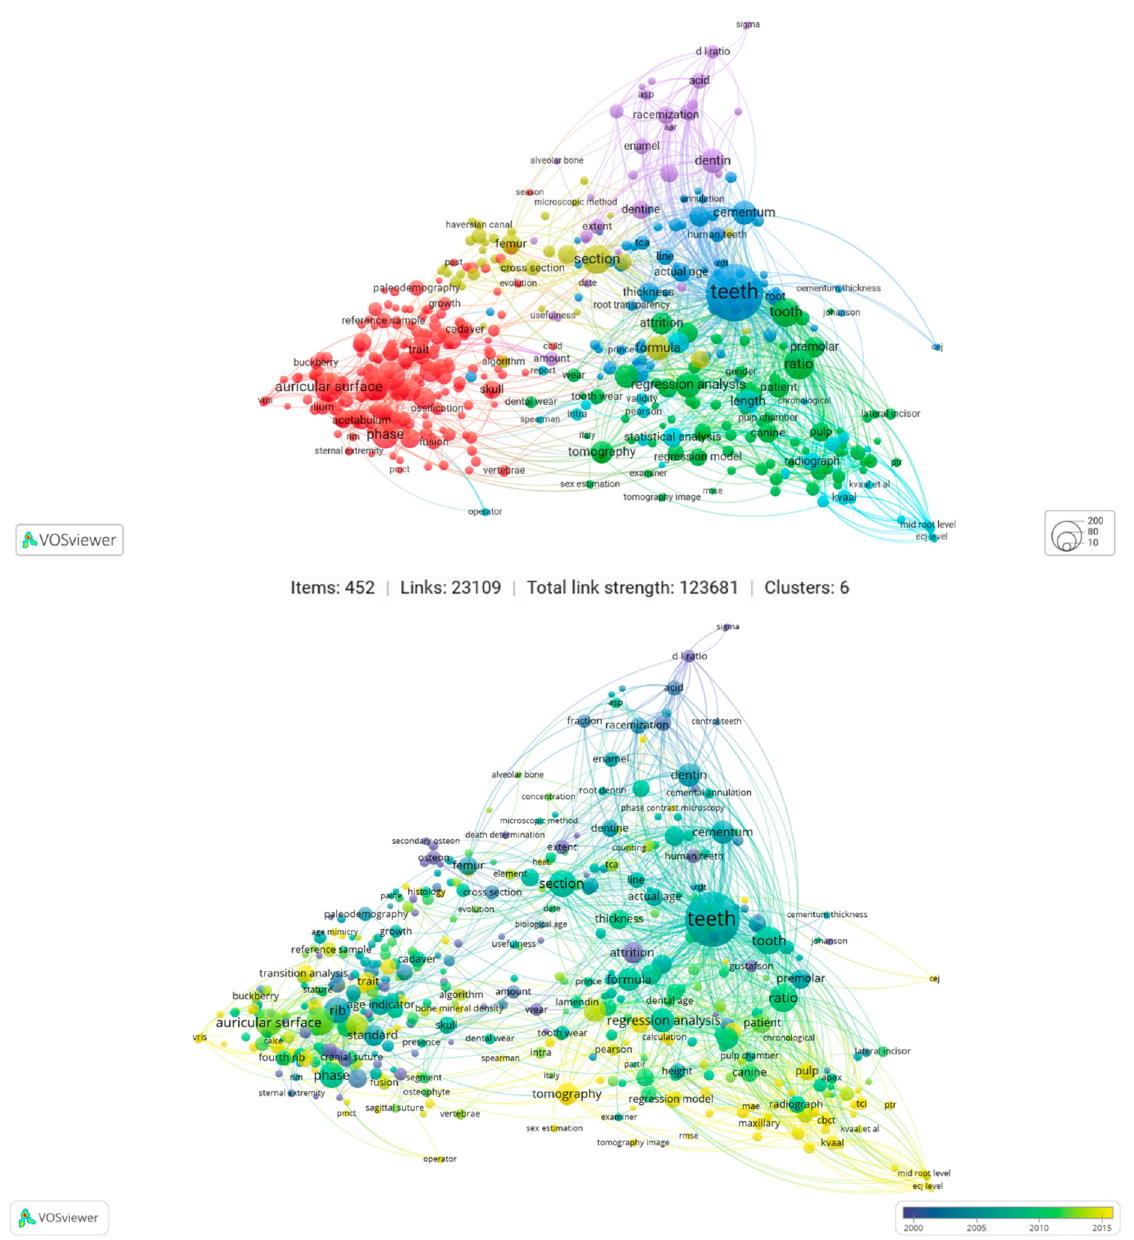
Figure 5. Upper image: network visualization co-occurrence of terms. Lower image: overlay visualization co-occurrence of terms per year. Co-occurrence of terms were extracted from the title and abstract using a full counting method. The minimum number of terms was set at 10; only 753 of the 17,172 terms met the requirement. VOSviewer then assigned a relevance score to each of the 753 terms and chose 60% of the most relevant terms. The analysis ultimately highlighted 452 terms and six clusters of term co-occurrences. Visible and interactable at